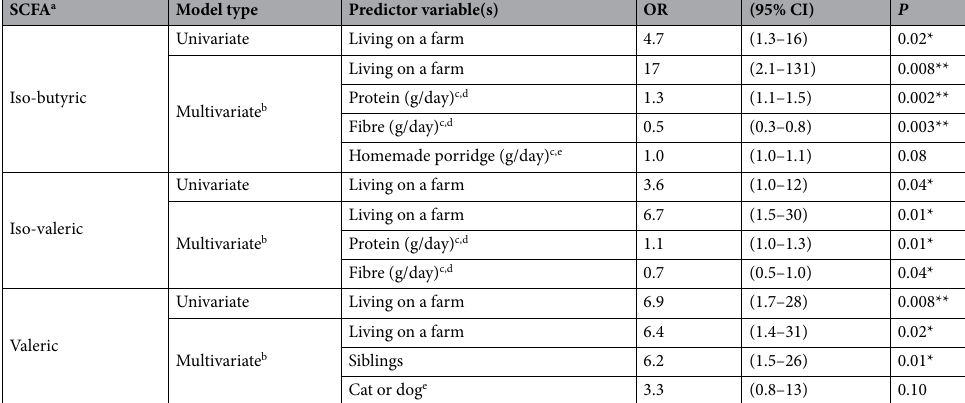
Table 3. Logistic regression models of demographic, family, birth and dietary characteristics on the associations between farm residence and high concentrations of fecal iso-butyric, iso-valeric and valeric acids at 3 years of age. * P < 0.05, binary logistic regression, n = 19 (farm) and 32 (control). a SCFA levels dichotomized as concentration of iso-butyric acid, > or ≤ 2.0 μmol/g; iso-valeric acid, > or ≤ 2.5 μmol/g; valeric acid, > or ≤ 2.0 μmol/g. b Final multivariate model. Additional variables related to farm residence and fecal SCFA concentration with P < 0.2, and therefore included in the model-building process, were: (iso-butyric acid) intake of homemade porridge and cream; (iso-valeric acid) cream; (valeric acid) father’s education level. Elder siblings and dietary intakes of protein and fibre were also included, as they have been linked theoretically with SCFA levels. c At 1 year of age. We hypothesized that intake at 1 year of age may well be similar to that at 3 years of age and/or may influence the development trajectory of the gut microbiota and short chain fatty acid profile. d,e The primary OR (d) increased or (e) decreased by ≥ 10% when the variable was removed and subsequently reintroduced into the model.